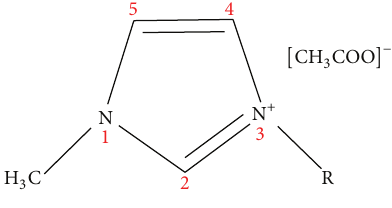
Figure 1: Schematic structures for the investigated ILs in the IL + DMSO